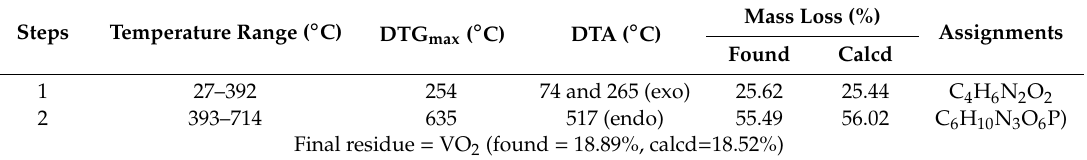
Figure 4. DTA curve of [(AMP)(VO)(H 2 O) 2 ] complex. Table 1. Thermal data of [(AMP)(VO)(H 2 O) 2 ] complex.